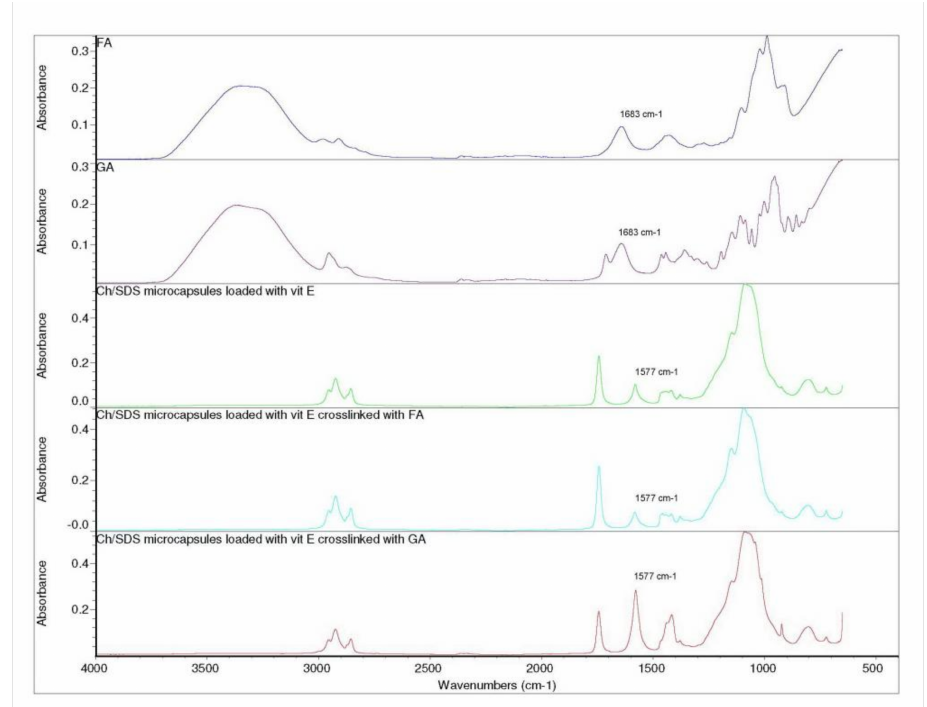
Figure 6. FTIR spectra of FA, GA, Ch/SDS microcapsules loaded with vitamin E without cross-linking agent, as well as cross-linked with FA (mass ratio 1:2) and GA (mass ratio 1:2),